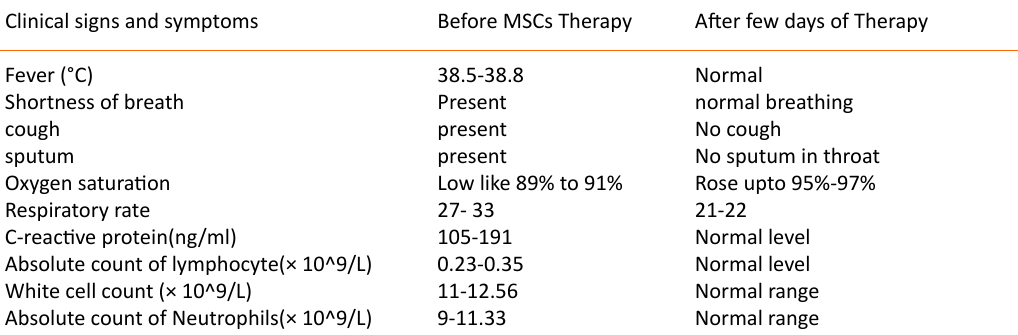
Table 1. Parameters of clinical symptoms before and after MSC Therapy Clinical signs and symptoms